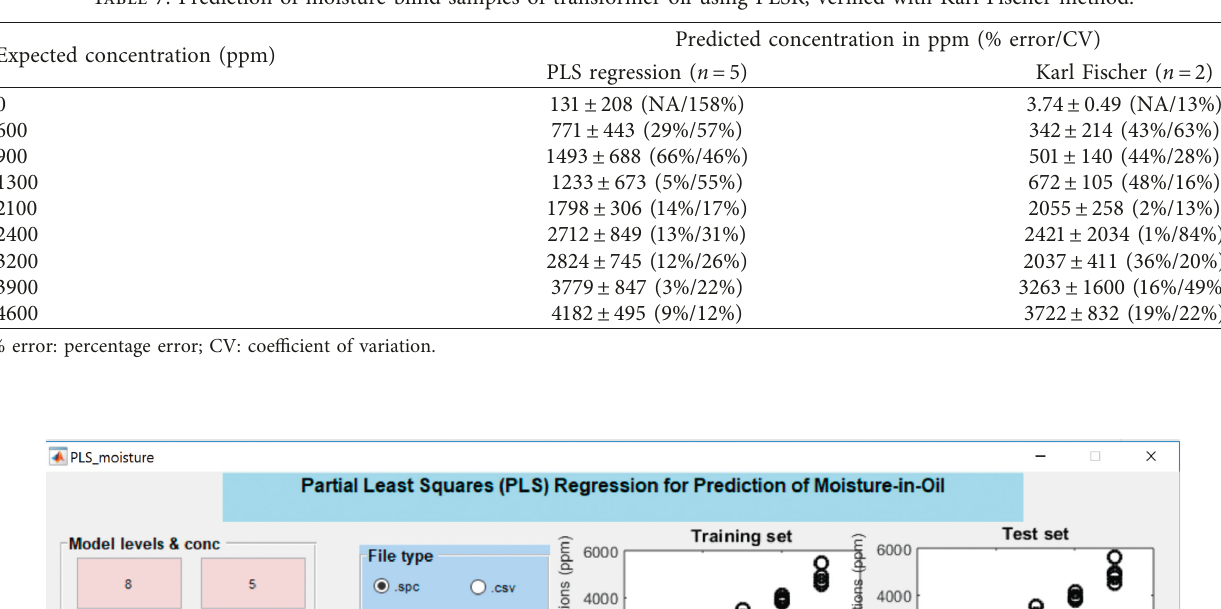
Table 7: Prediction of moisture blind samples of transformer oil using PLSR, verified with Karl Fischer method.